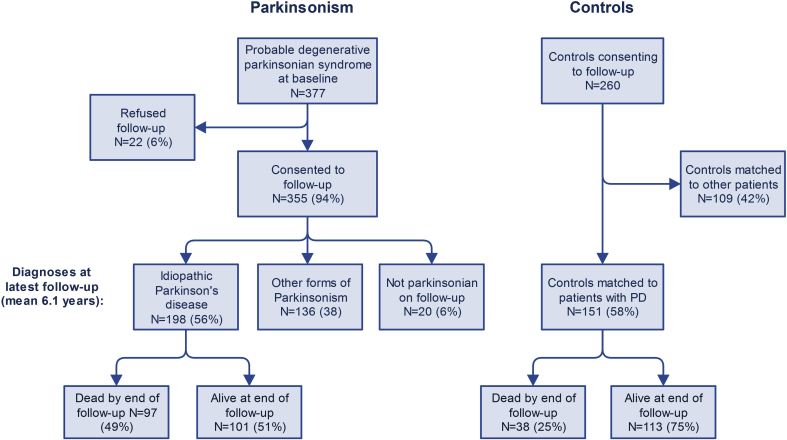
Flowchart of patients and controls in the PINE study.